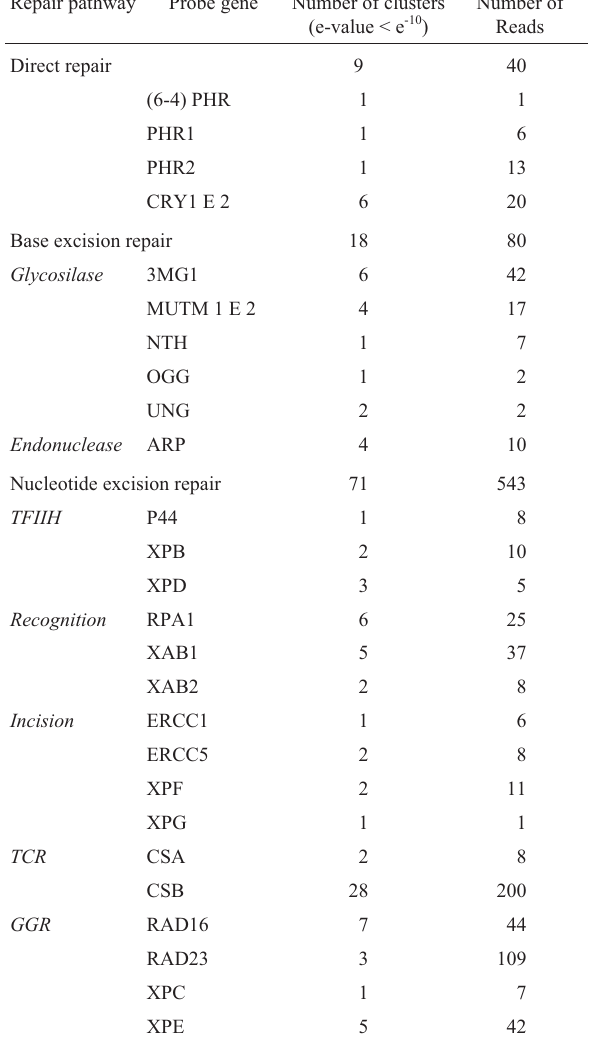
Table II - Number of clusters and reads identified in the SUCEST Data